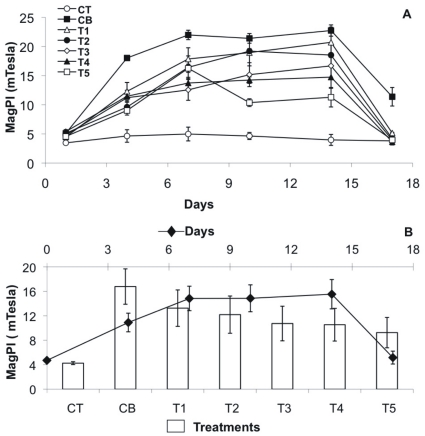
Biofilm adhesion as a proxy for stability, measured by MagPI, over the course of the experiment.(A) Mean values (n = 4 per treatment) with SE of the different treatments over time: positive control CB (black squares), negative control CT (white circles), T1 (TCS: 2 µg/L, white triangles), T2 (TCS: 10 µg/L, black circles), T3 (TCS: 20 µg/L, white diamonds), T4 (TCS: 50 µg/L, black triangle), T5 (TCS: 100 µg/L, white squares). (B) Mean values with SE per day (n = 7, black diamonds) and per treatment (n = 6, bar plots).